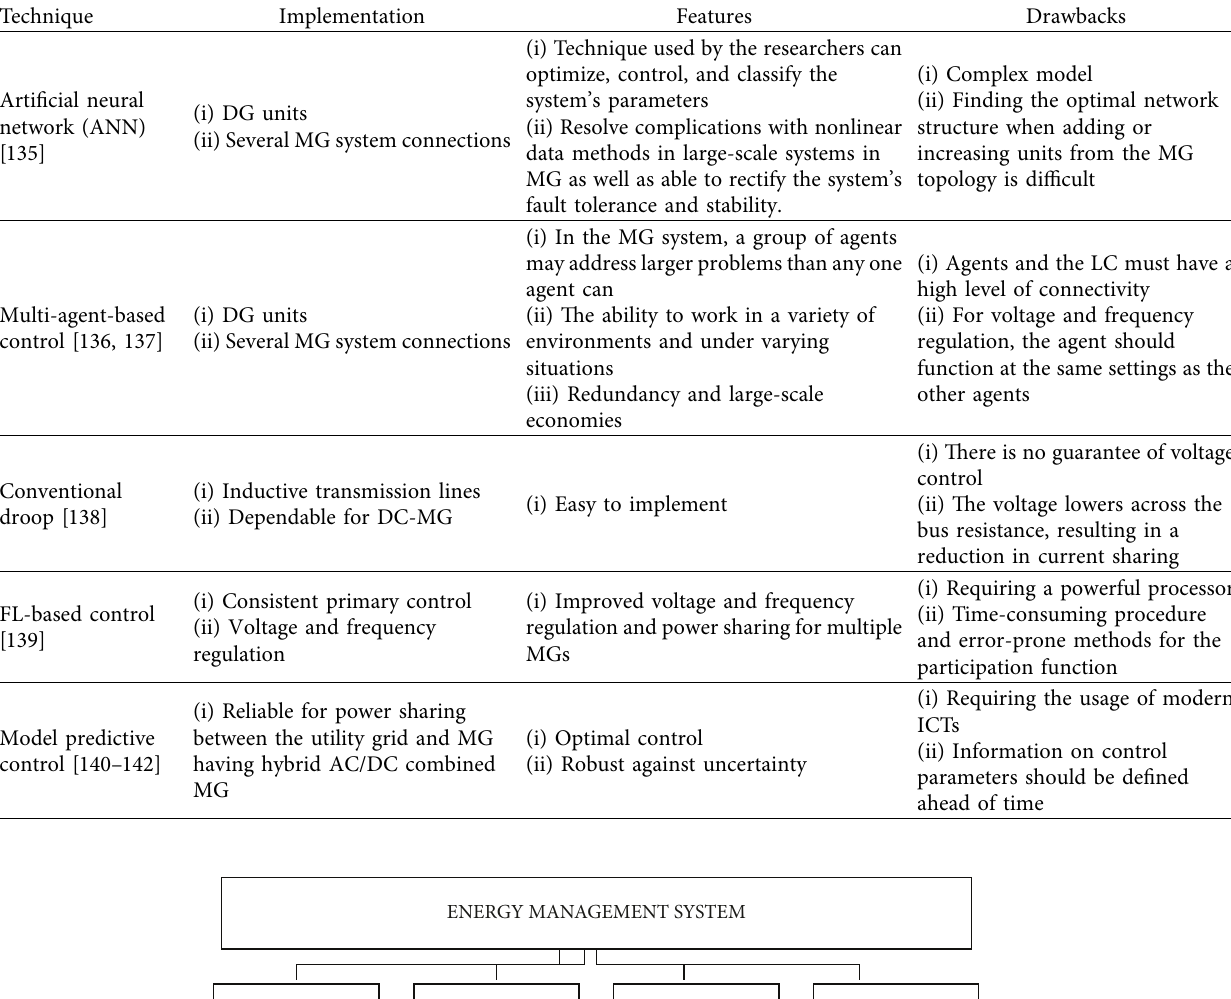
Table 6: Comparison analysis of microgrid control approaches.